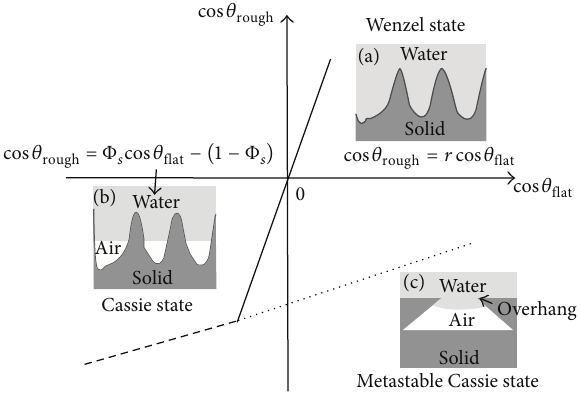
Figure 3: Relationships of cos 𝜃 adapted from